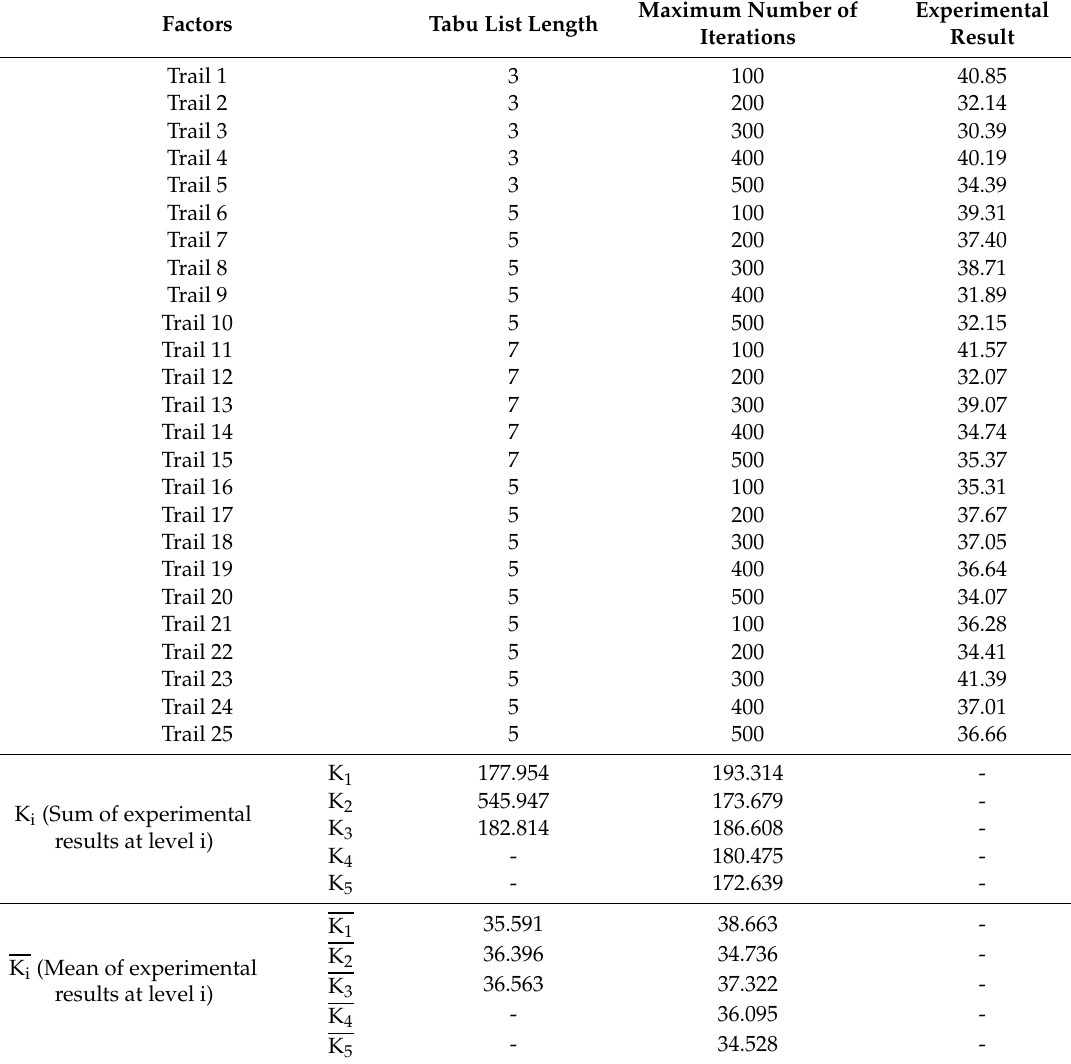
Table A2. Orthogonal experimental design table of the NTS